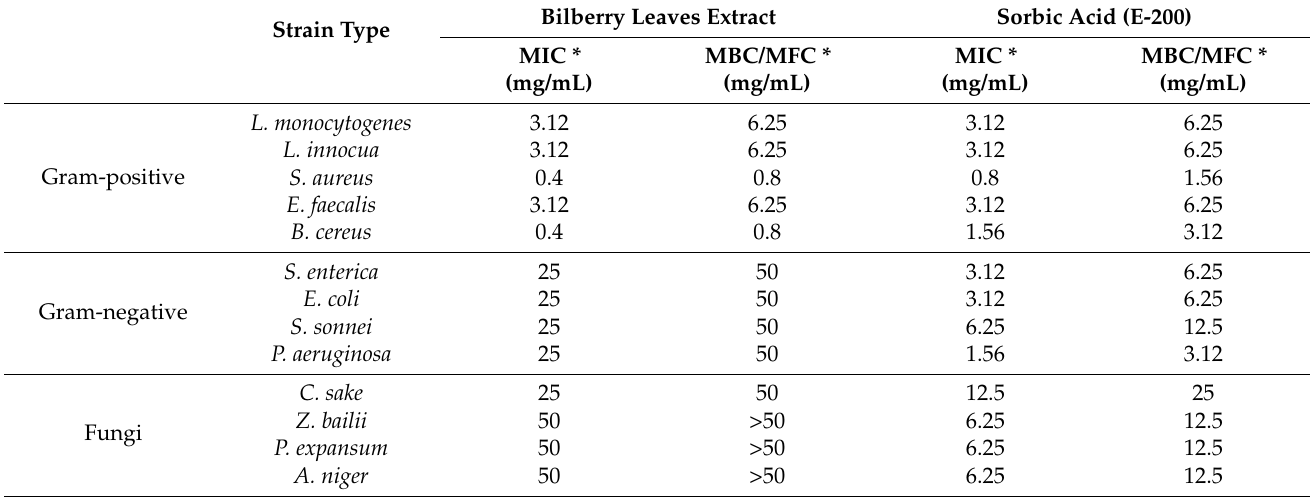
Table 5. Minimum inhibitory concentration (MIC), minimum bactericidal concentration (MBC) and minimum fungicidal concentration (MFC) of bilberry leaves extract and sorbic acid (E-200) as positive